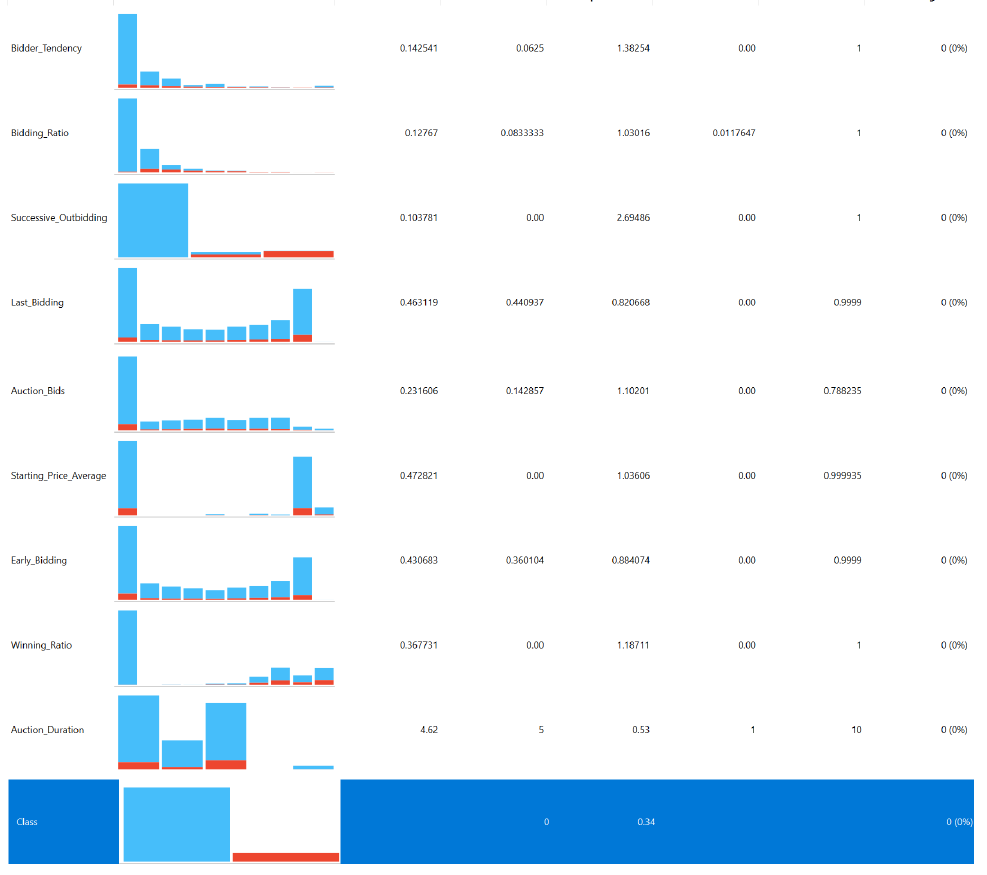
Figure 5. Statistical values and the data distribution—Auction Fraud data